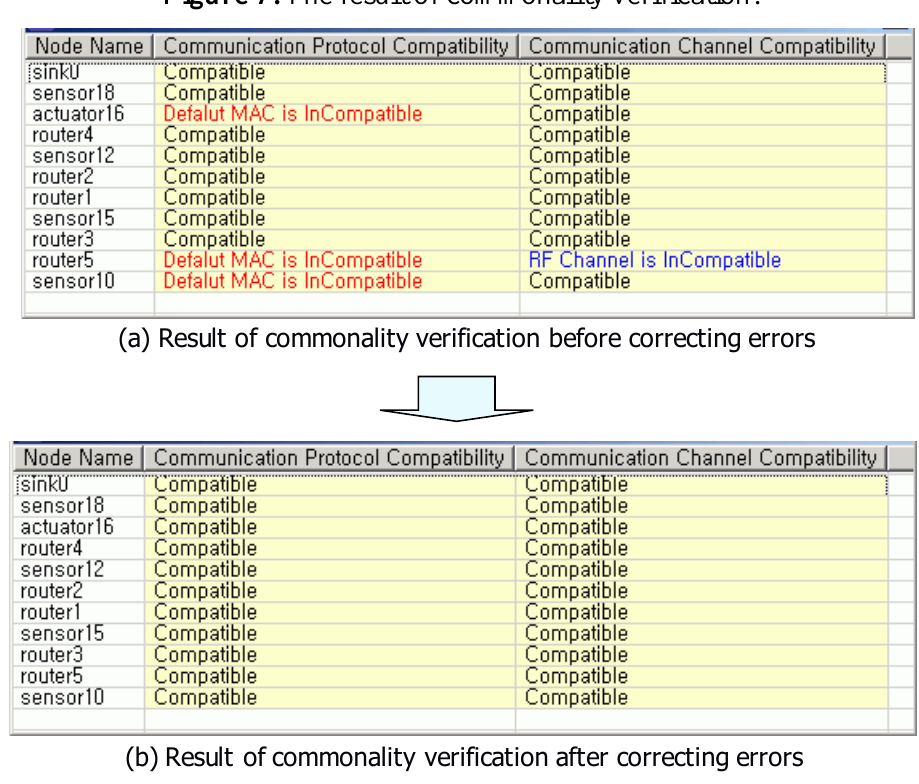
Figure 7. The result of commonality verification.